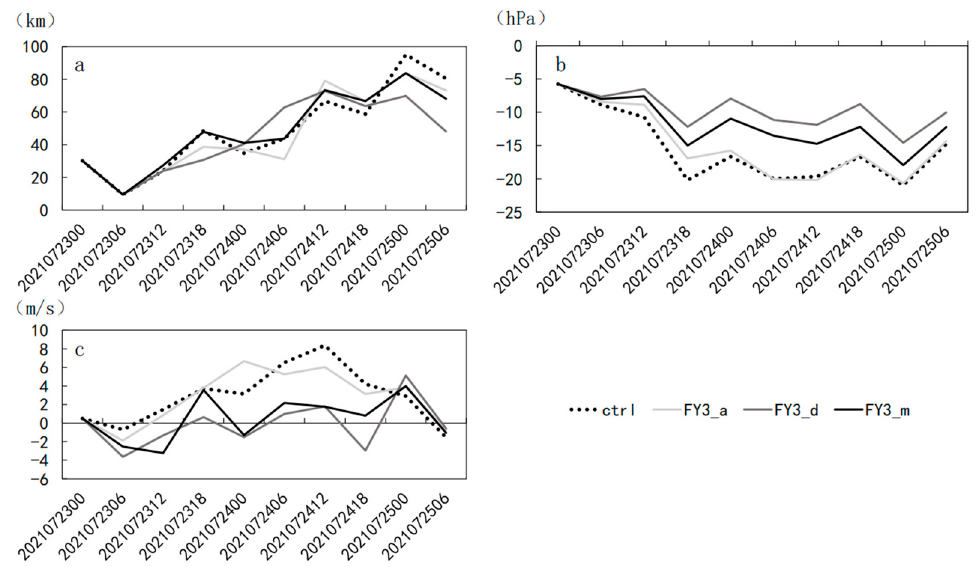
Figure 10. Mean track errors (( a ), unit: km), mean central sea level pressure errors (( b ), unit: hPa) and mean maximum surface wind speed errors (( c ), unit: m · s − 1 ) as a function of forecast range from four experiments.